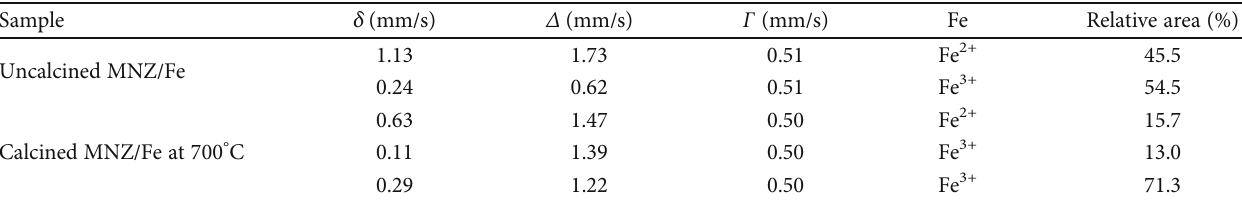
Figure 5: Mössbauer spectra of MNZ/Fe: (a) uncalcined at 25 ° C and (b) calcined at 700 ° C. Table 4: Mossbauer parameters of MNZ/Fe samples.